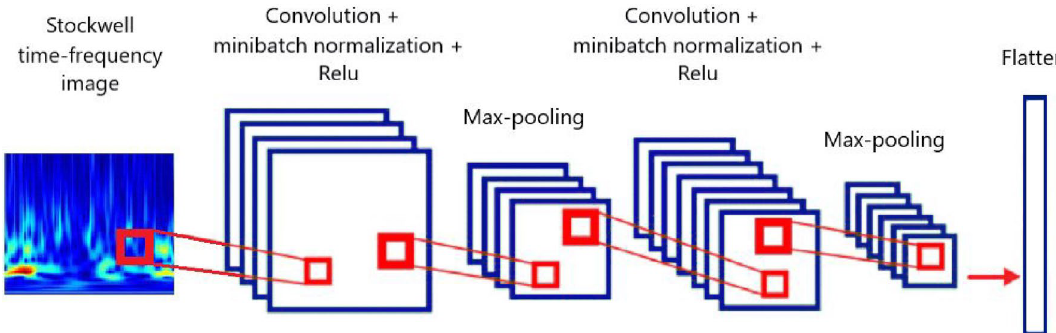
Figure 7. The structure of CNN with two convolutional